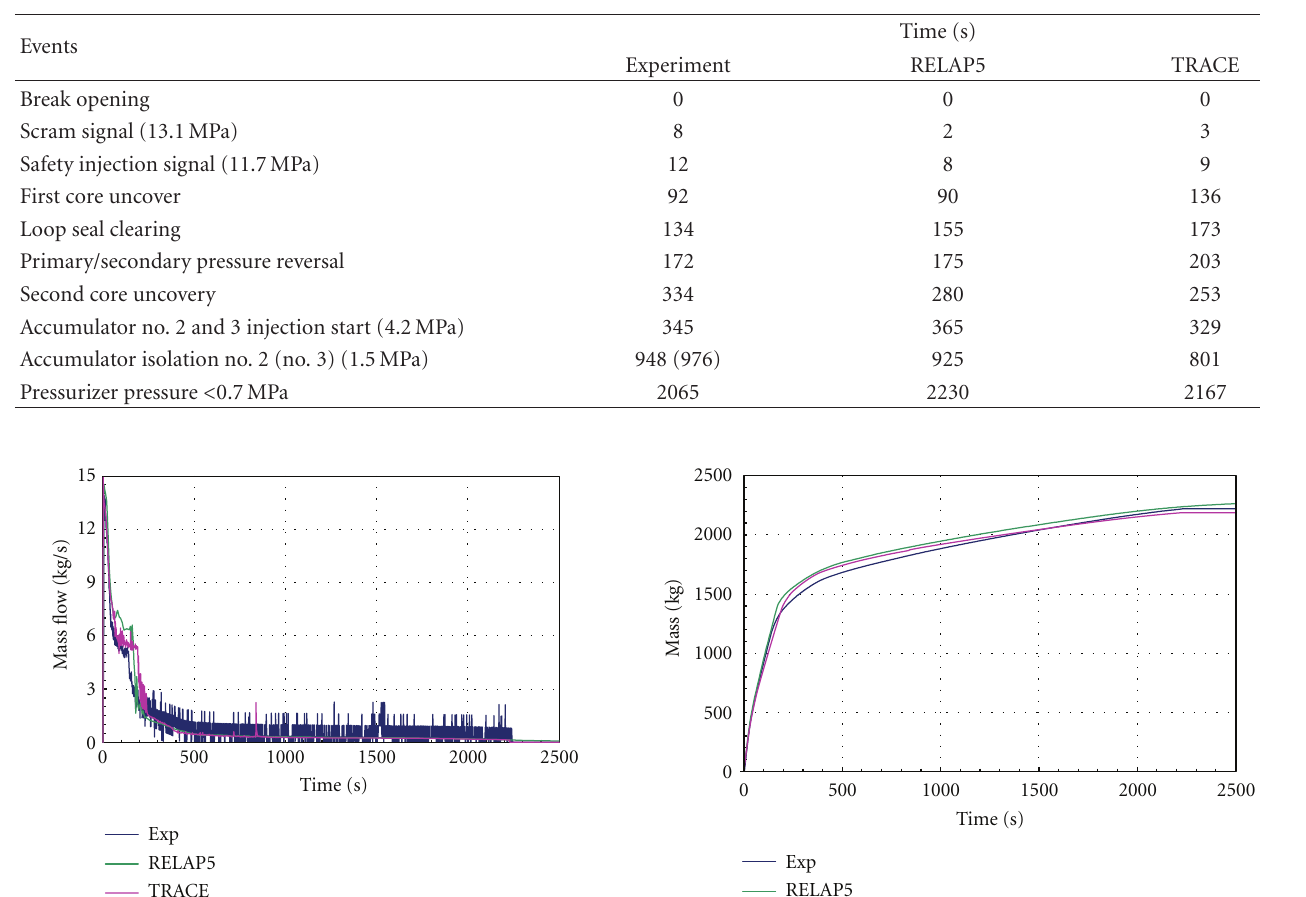
Table 2: Main sequence of events.